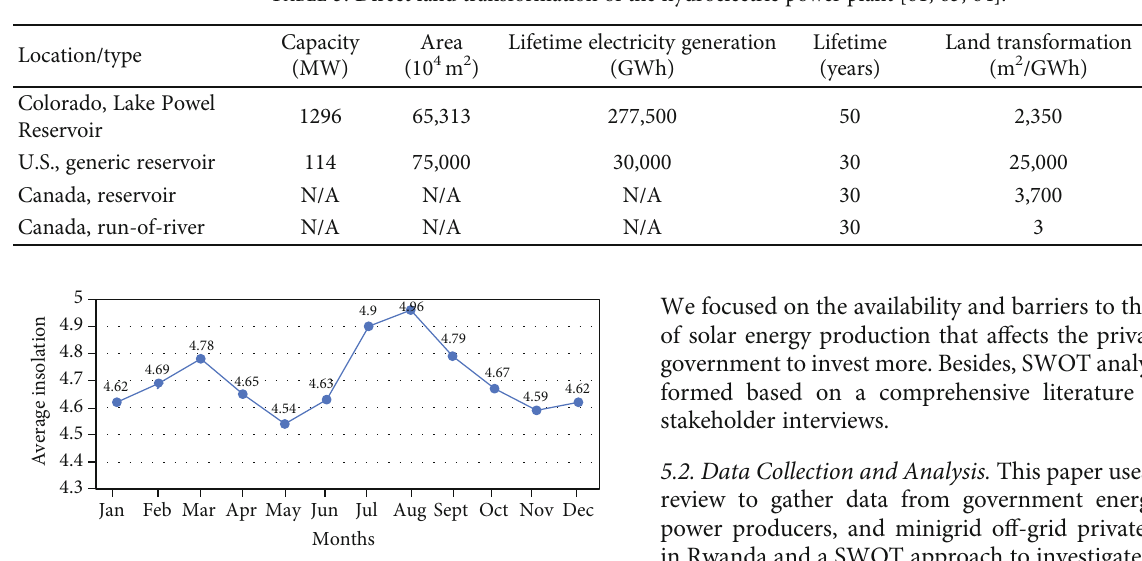
Table 3: Direct land transformation of the hydroelectric power plant [61, 63, 64].